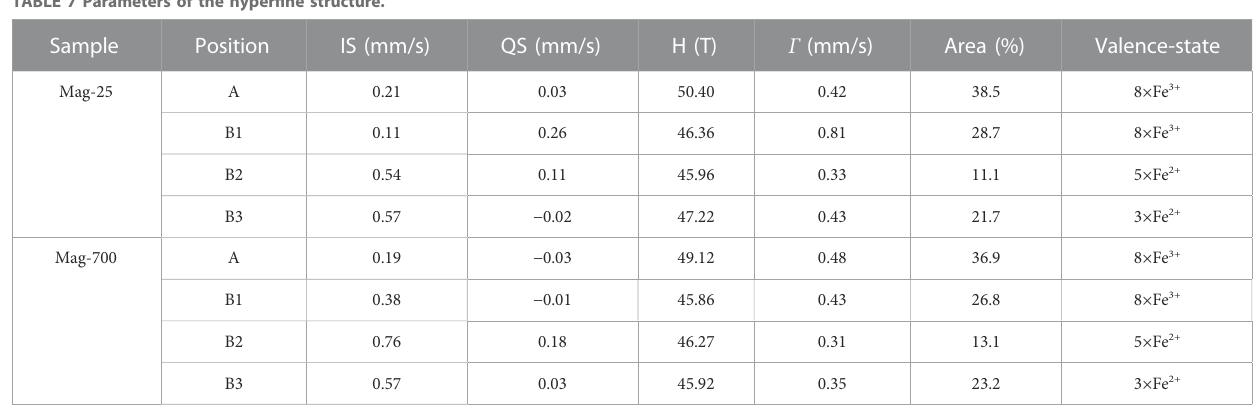
TABLE 7 Parameters of the hyper fi ne